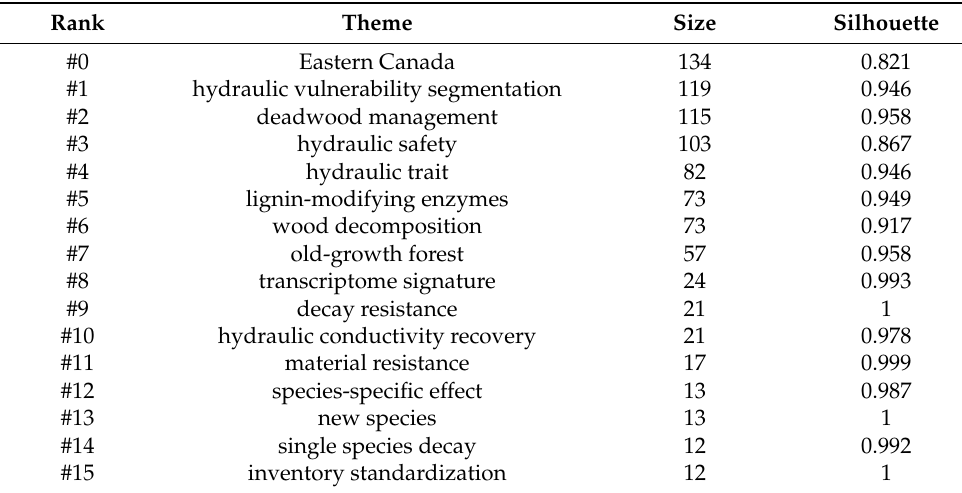
Figure 5. A clustering timeline view of co-cited literature. Table 2. Clustering information of the co-cited reference.